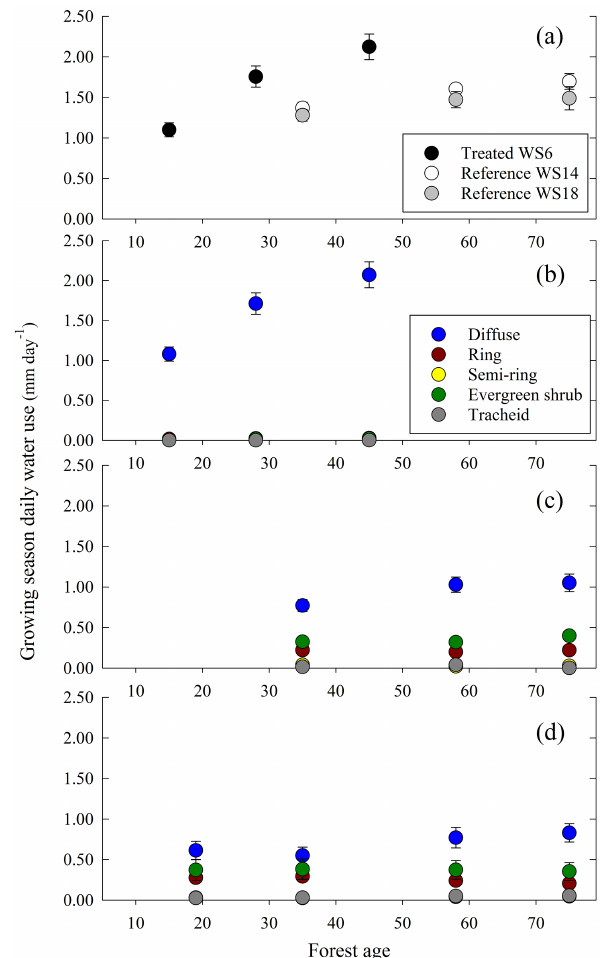
Figure 7. (a) Mean ( ± SE bars) growing-season daily water use (DWU) versus forest age in the treated WS6 and refer- ence (WS14, WS18) watersheds; (b) DWU versus forest age in treated WS6 by xylem functional group (diffuse-porous, ring- porous, semi-ring porous, evergreen shrub, and tracheid); (c) DWU versus forest age in reference WS14 by xylem functional group; and (d) DWU versus forest age in reference WS18 by xylem functional